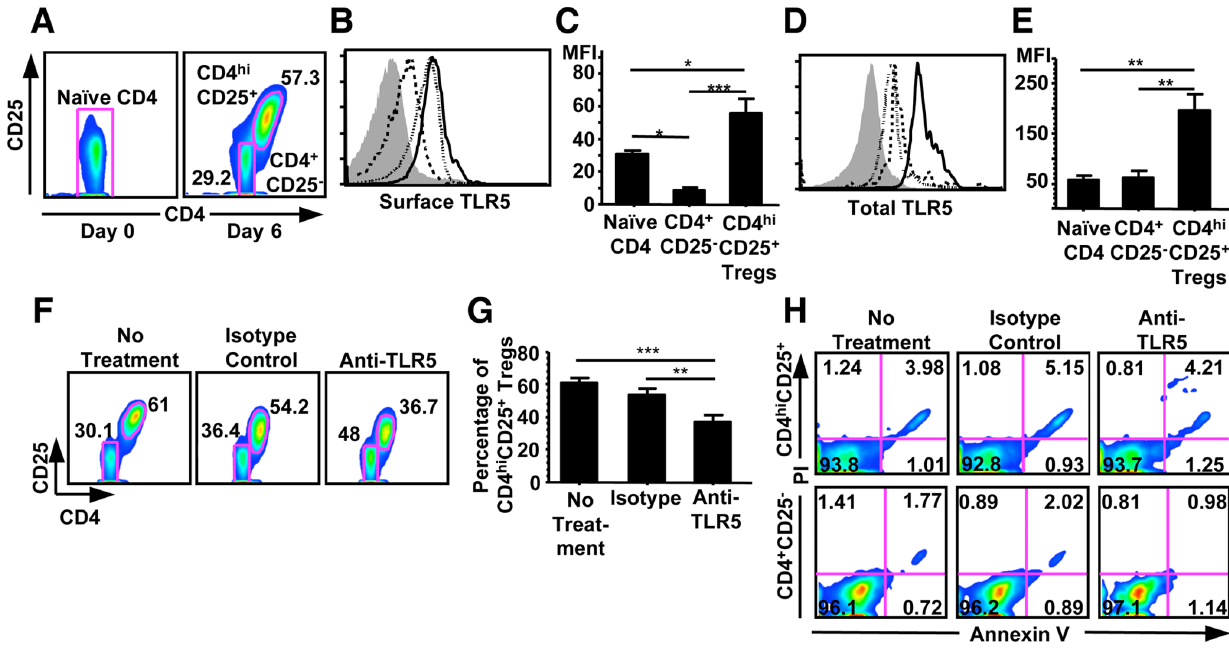
Figure 1. LR5 blockade reduced the generation of CD4 hi CD25 + regulatory T cells and was independent of apoptosis. (A) Flow cytometric analysis of the percentage of CD4 hi CD25 + regulatory T cells generated on Day 6 (right panel) from naı¨ve CD4 + CD25 2 CD45RO 2 T cells (left panel). (B) Flow cytometric analysis of the expression of surface TLR5 in freshly isolated naı¨ve CD4 + CD25 2 CD45RO 2 T cells (dotted line), and CD4 + CD25 2 (dashed line) and CD4 hi CD25 + regulatory T cells (solid line) after 6 days of co-culture of naı¨ve CD4 + CD25 2 CD45RO 2 T cells with allogeneic CD40-activated B cells. Filled histogram indicates the staining obtained from isotype-matched mAb controls. (C) Mean fluorescence intensity (MFI) of the expression of surface TLR5. Data show Mean + SEM, n =6. (D) Flow cytometric analysis of total TLR5 in freshly isolated naı¨ve CD4 + CD25 2 CD45RO 2 T cells (dotted line), CD4 + CD25 2 (dashed line), and CD4 hi CD25 + regulatory T cells (solid line) after 6 days of co-culture of naı¨ve CD4 + CD25 2 CD45RO 2 T cells with allogeneic CD40-activated B cells. Filled histogram indicates the staining obtained from isotype-matched